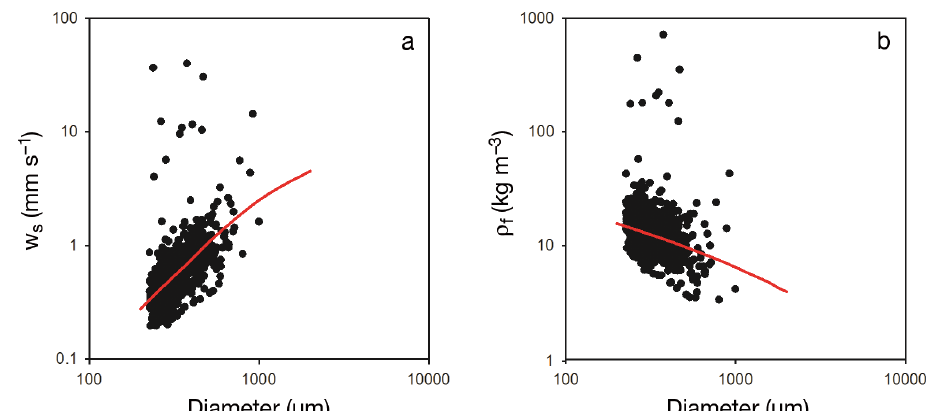
Fig.6.Unbinned particle (a) size-versus-settling velocity (w s ) and (b) size-versus-effective density ( ρ f ).The particle effective densities were estimated using a modified Stokes’ Law. The red line in each of the panels represents the Khelifa & Hill (2006) fit of the